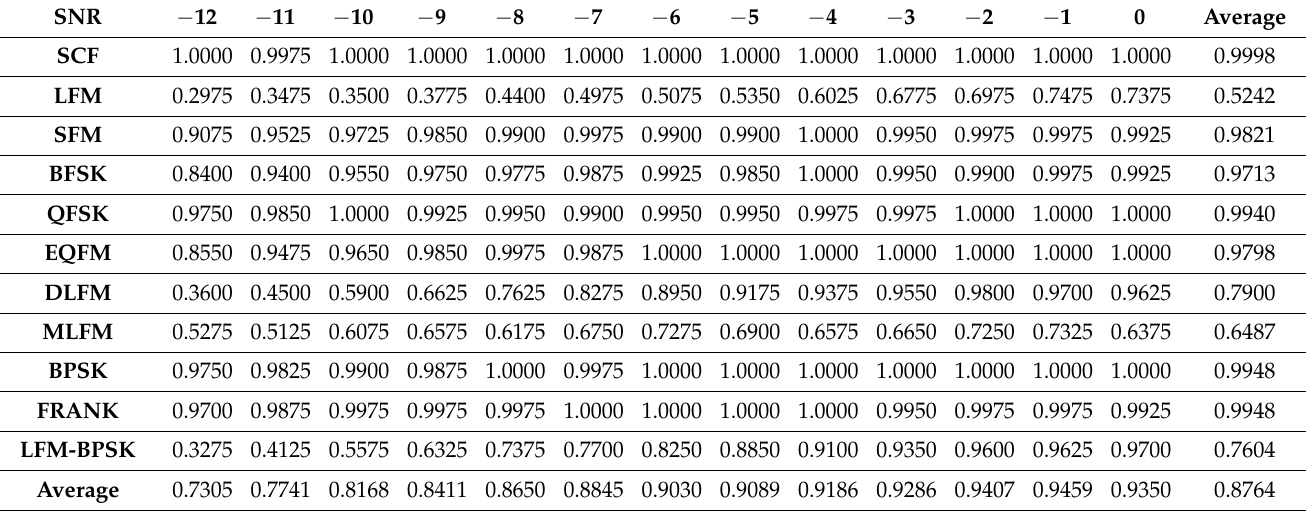
Table A5. Semi-supervised classification results of our proposed method with the datasets in Situation Dataset 5.